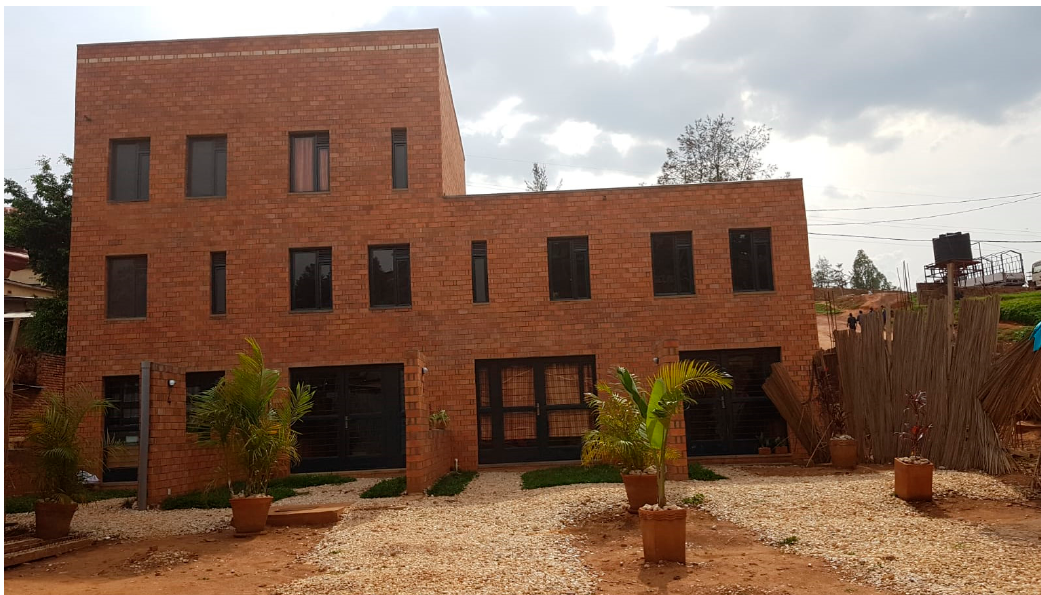
Figure 4. First inaugurated apartment block for affected households at the Mpazi research site. Source: 302 This picture was taken by the first author in March 2019. Table 1. Overview of research